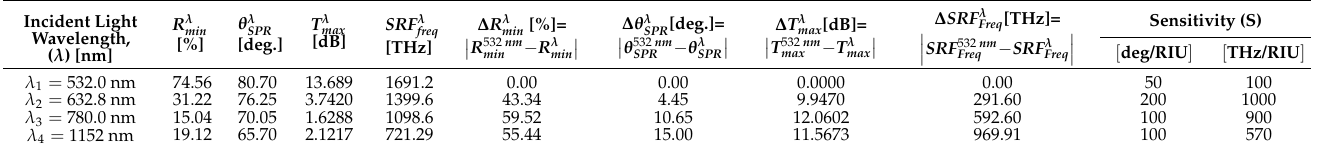
Figure 5. Schematic diagram of: ( a ) SPR and ( b ) SPRF curve characteristics of Bk 7 /Au(50 nm)/PtSe 2 (2 nm)/Graphene(1.7 nm)/ (cid:16) (cid:17) λ light PBS (RI = 1.3348) layered model with variation in incident light wavelength . Table 2. Data evaluation of ∆ R λ , ∆ θ λ , ∆ T λ max and ∆ SRF λ , and sensitivity (S) attributors with change of incident Freq SPR min (cid:16) (cid:17) λ light wavelength in the proposed SPR